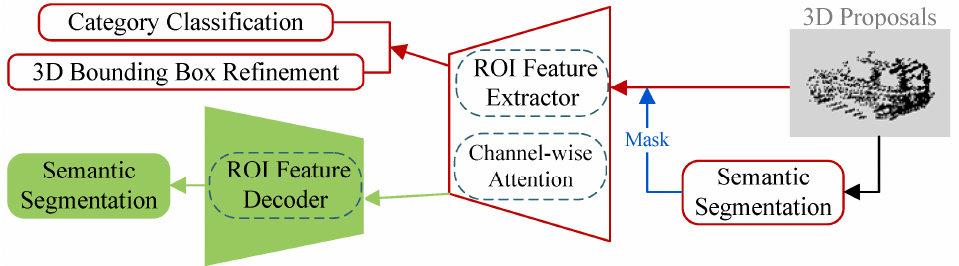
Figure 11. Comparison of three semantic segmentation branch designs. The three designs are shown in black, blue and